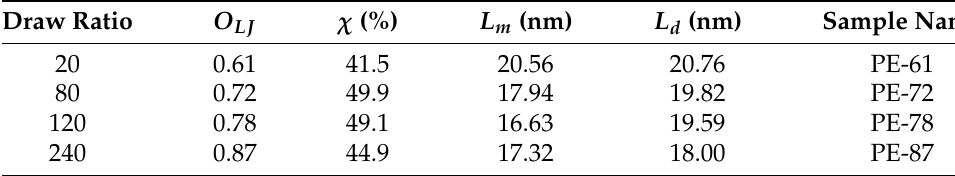
Table 1. Structural information of mLLDPE precursor